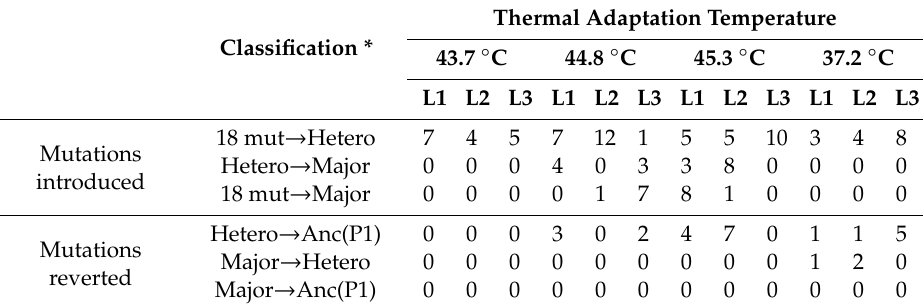
Table 2. Number of mutations introduced with adaptation to increased temperature and numbers that reverted back to the original sequence.